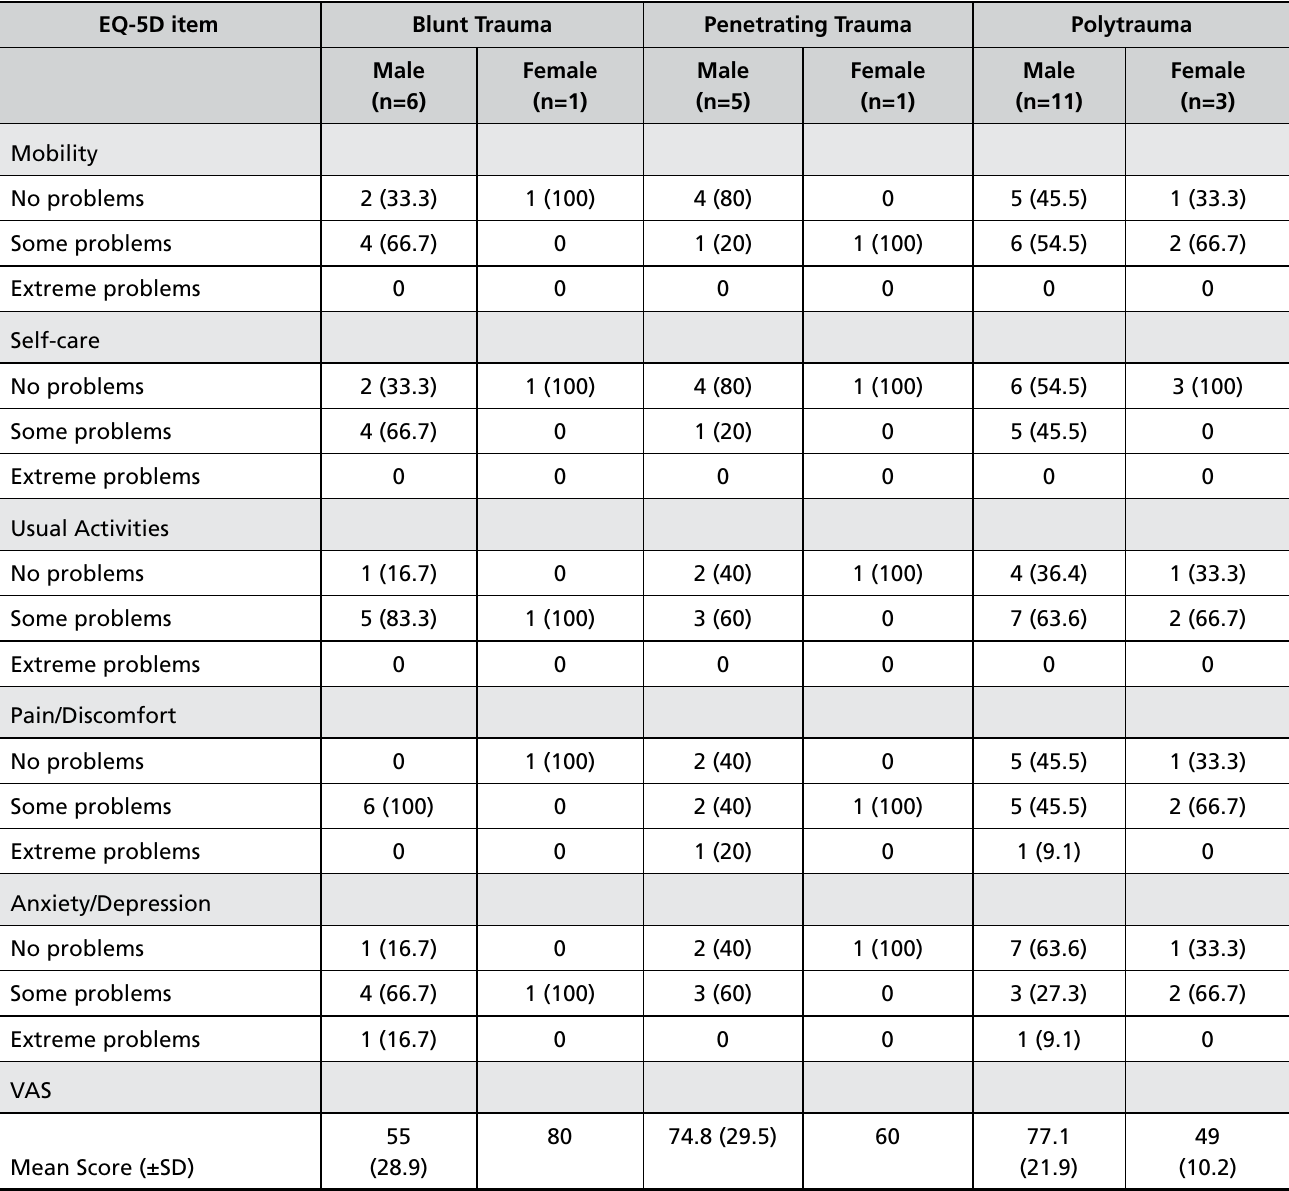
table iii: comparison of eQ-5D items with trauma type and gender (n = 27) eQ-5D item